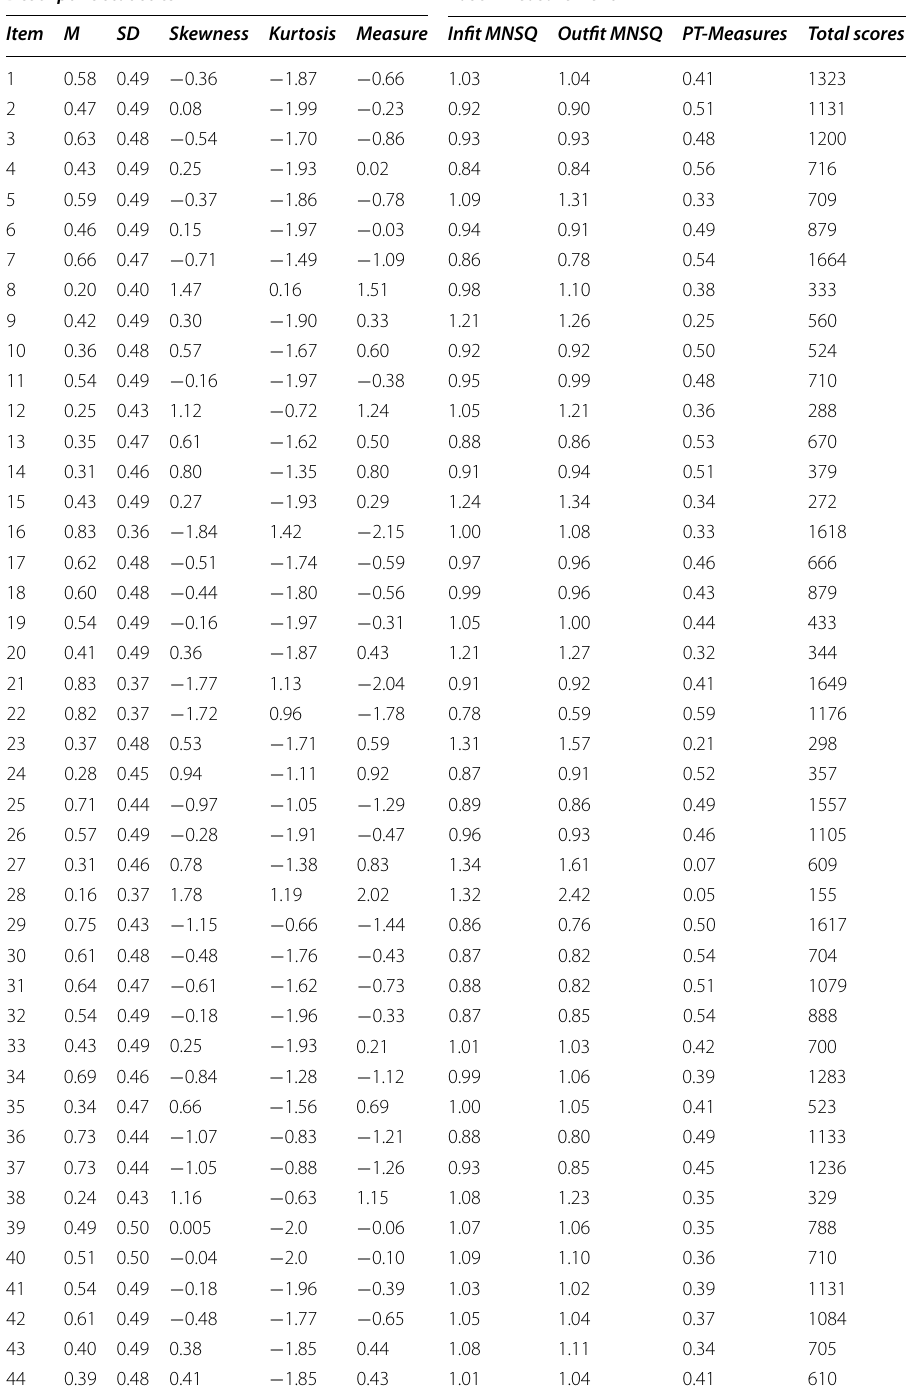
Table 17 Results of descriptive statistics analysis and Rasch measurement (IUUESEE